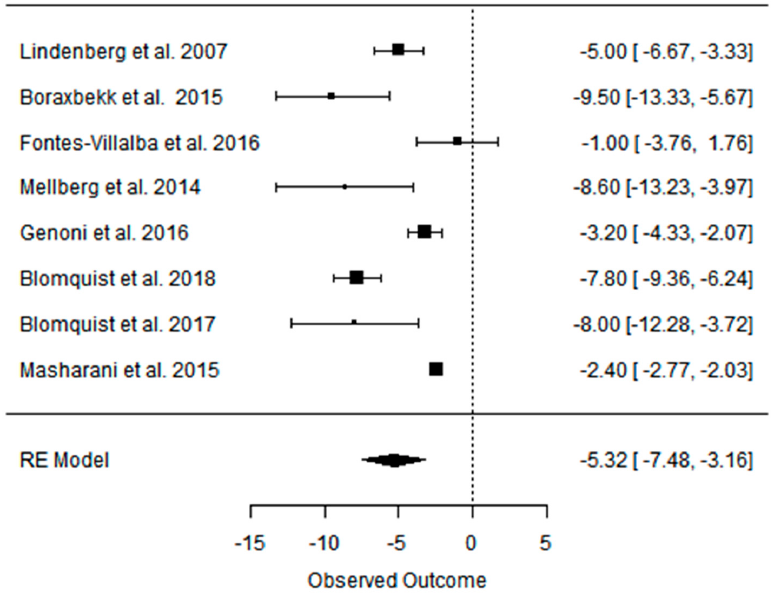
Figure A2. Forest plot of the effect of PD on BM (kg) in the short term (weighted mean difference).